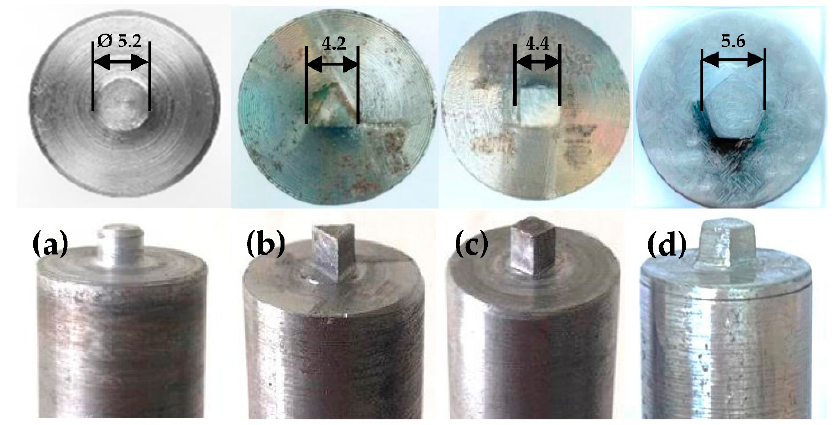
Figure 2. Different tool pin geometry for friction stir welding process (FSWp) of SSM 6063 aluminum alloys: ( a ) cylindrical, ( b ) triangular, ( c ) square, and ( d ) pentagon.